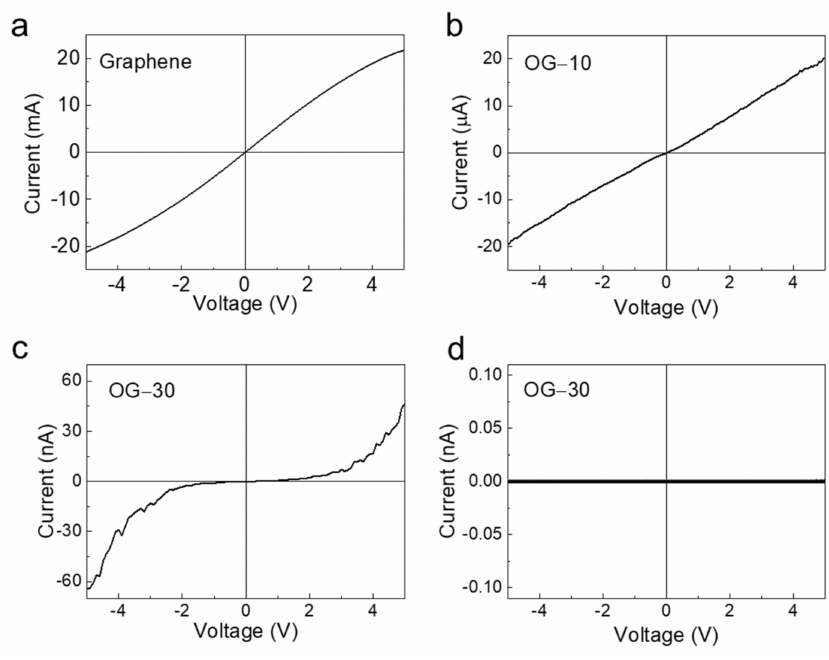
Figure 2. Current-voltage (I-V) curves of ( a ) graphene, ( b ) OG-10, ( c ) OG-20, and ( d ) OG-30.